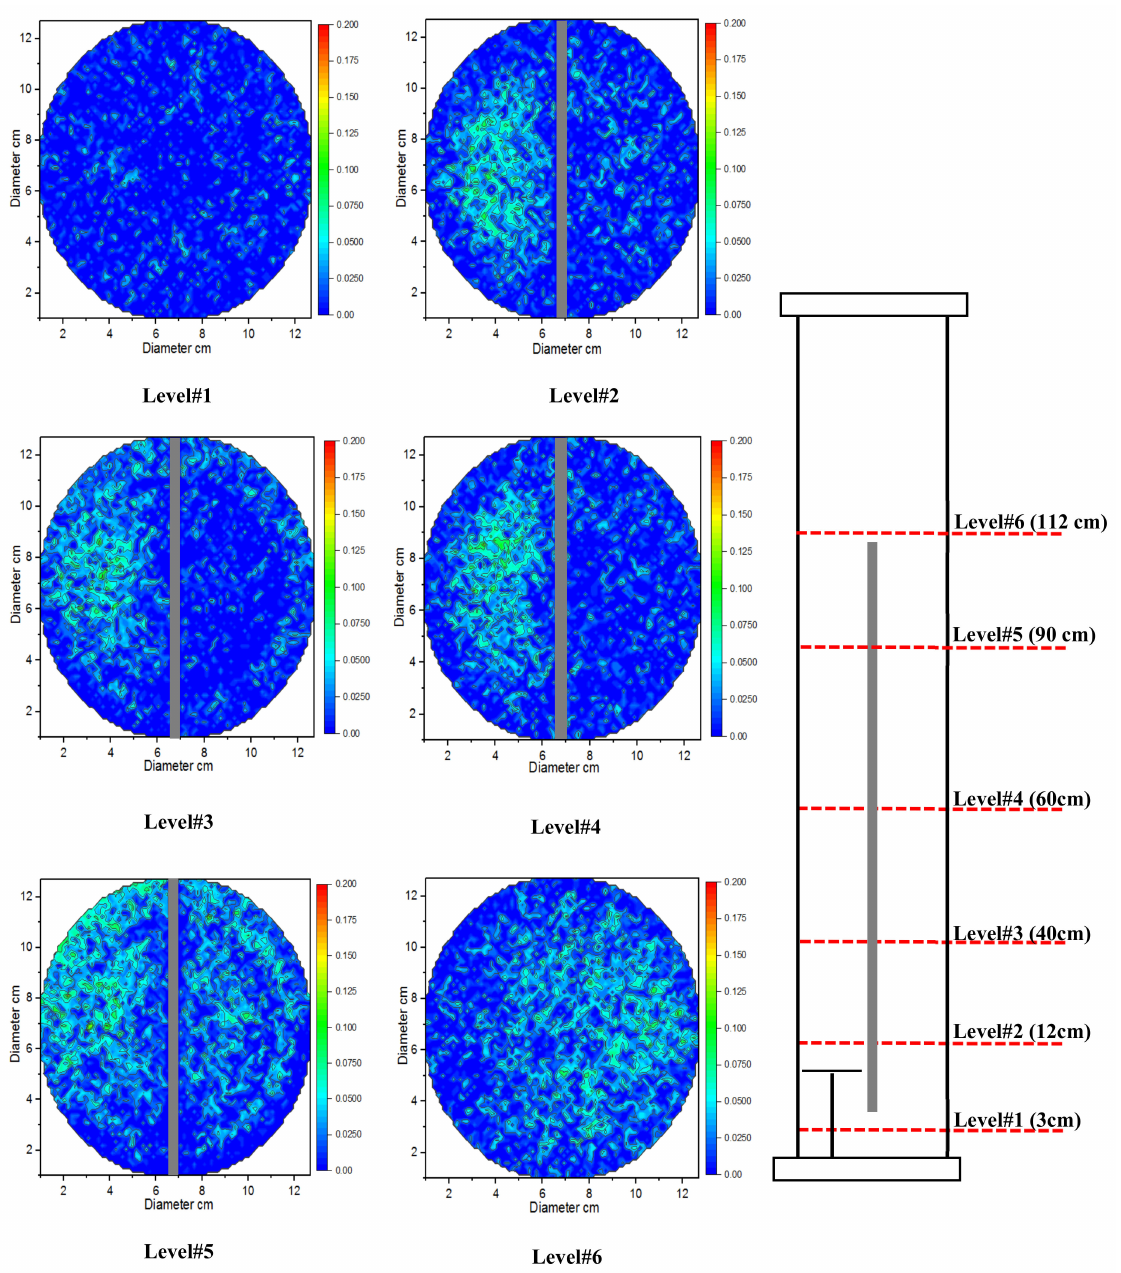
Figure 8. Cross-sectional distributions in gas holdup at different heights of split airlift reactor operated with gas velocity of 1